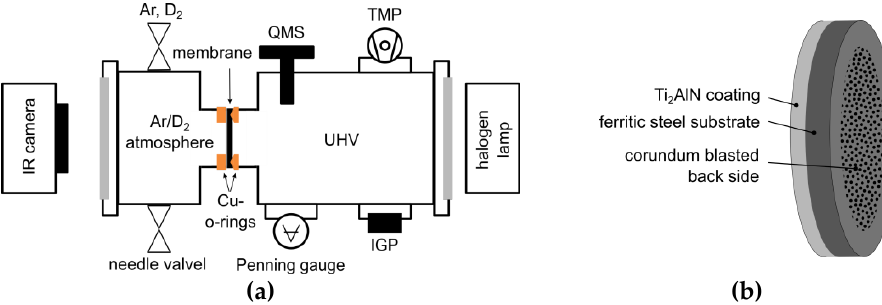
Figure 1. ( a ) Schematic illustration of the hydrogen permeation test rig with quadrupole mass spectrometer (QMS), turbomolecular pump (TMP) and ion getter pump (IGP). ( b ) Schematic illustration of the coated ferritic steel membrane.